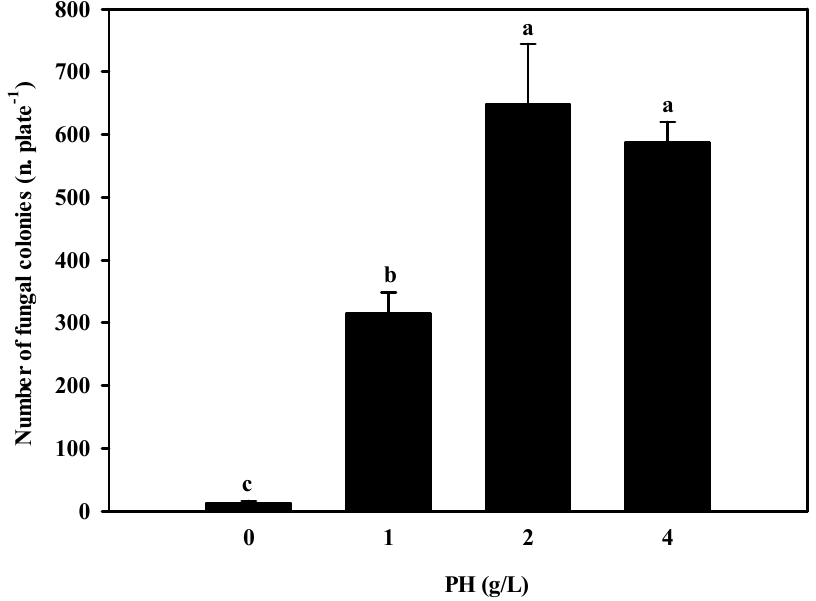
Figure 2. Effect of protein hydrolysate (PH) rate on number of Trichoderma atroviride colonies per plate after 4 days of incubation. Bars represent standard errors of the means. Means with different letters are significantly different according to Duncan’s test ( p ≤ 0.05) (Experiment 3).